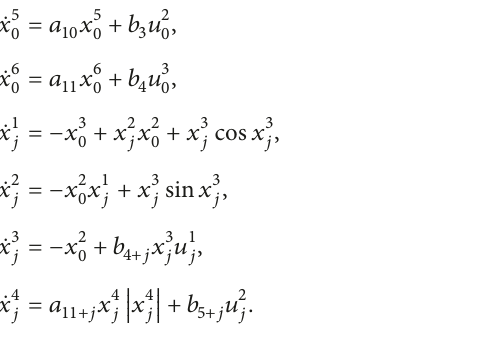
Figure 3: Diagram of the differential game model of moving objects control